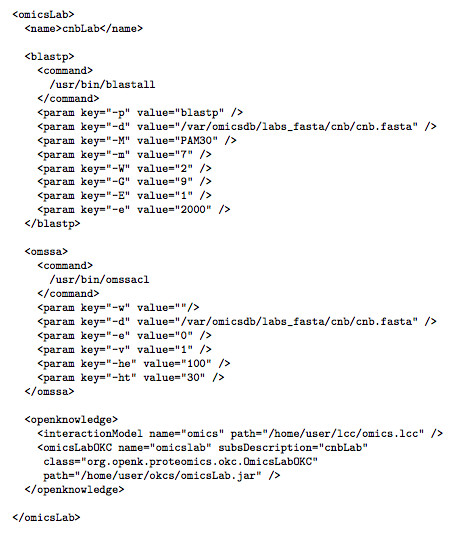
Fragment of the configuration file used by the omicslab peers.